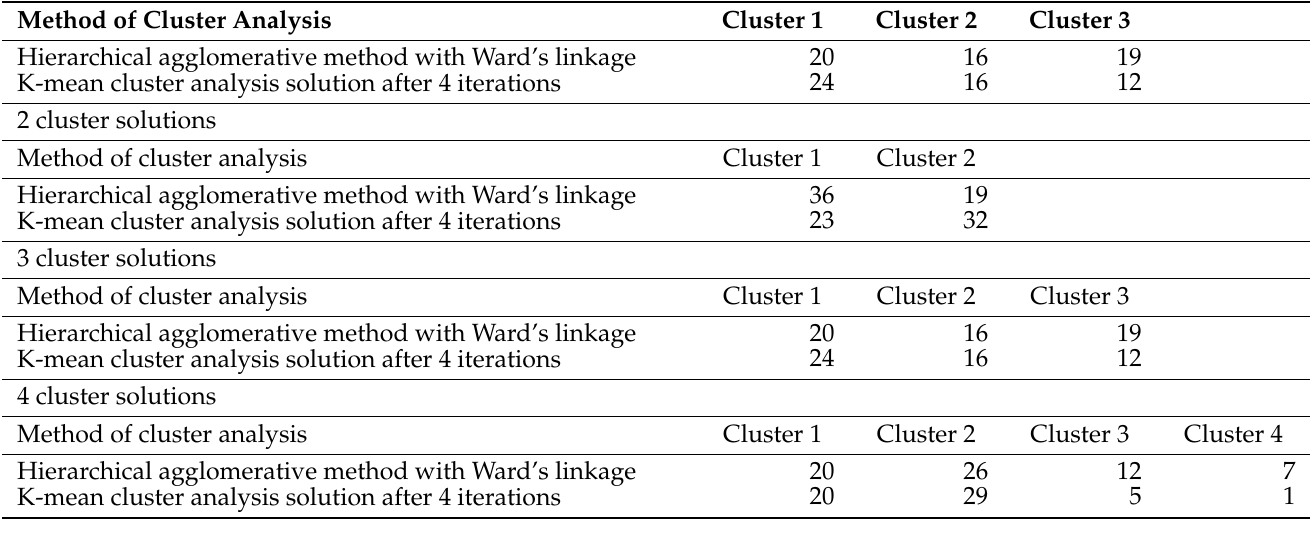
Table 3. The numbers of members per cluster for the 2, 3, and 4 cluster solutions produced by two cluster analysis methods.